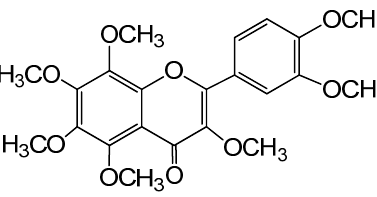
Figure 1. Structure of 3,5,6,7,8,3 ′ ,4 ′ -heptamethoxyflavone (HMF).